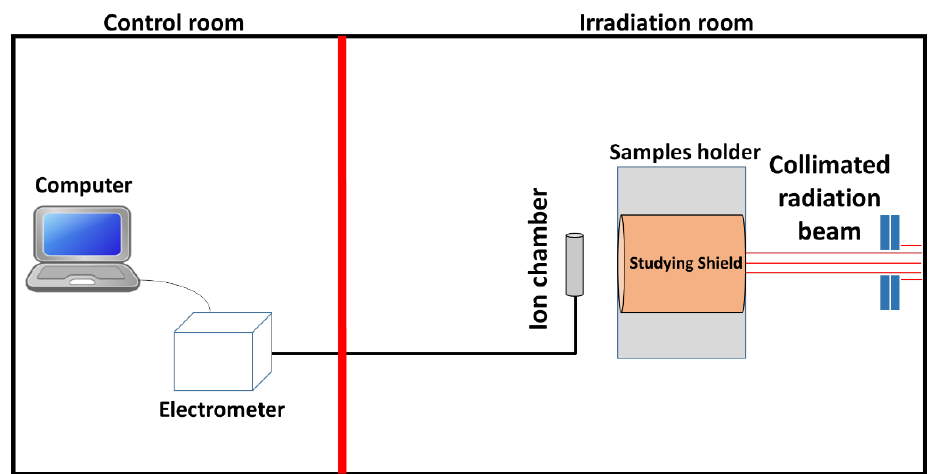
Figure 2. The radiation transmission experimental setup, showing the radiation beam passing through the studied samples and detected by the ionization chamber.